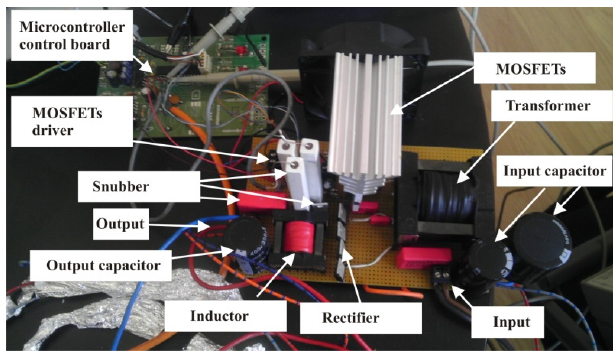
Figure 6. Hardware prototype of push–pull converter.